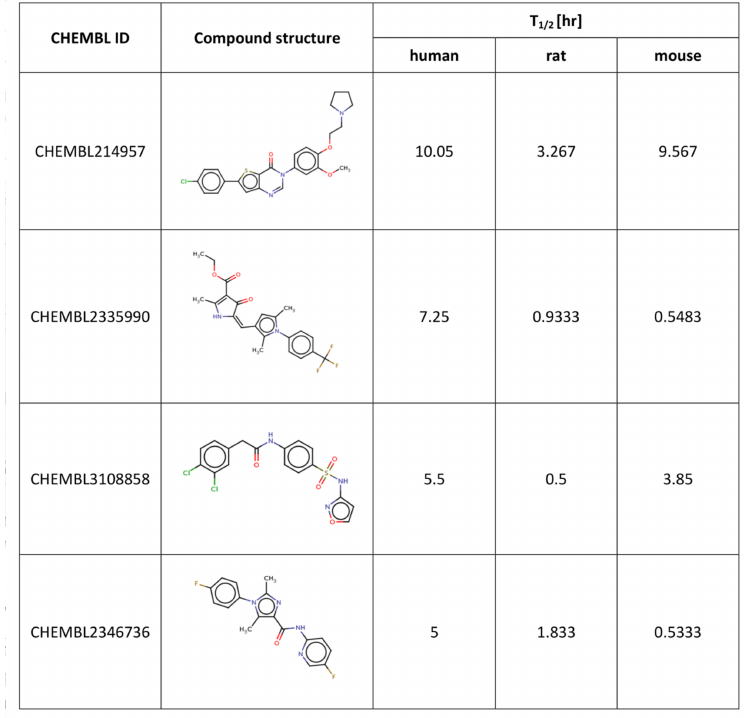
Figure 4. Examples of differences in results of metabolic stability tests for human, rat and mouse